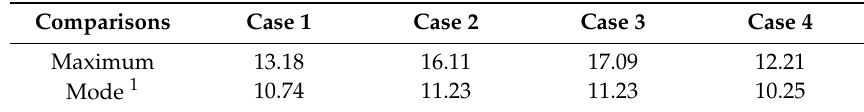
Figure 12. Fitting distribution of primary frequencies of vibration response of incursion range under different simulated intrusion cases. Table 1. Primary frequency characteristics of the different intrusion cases within the experimental area (unit: Hz).